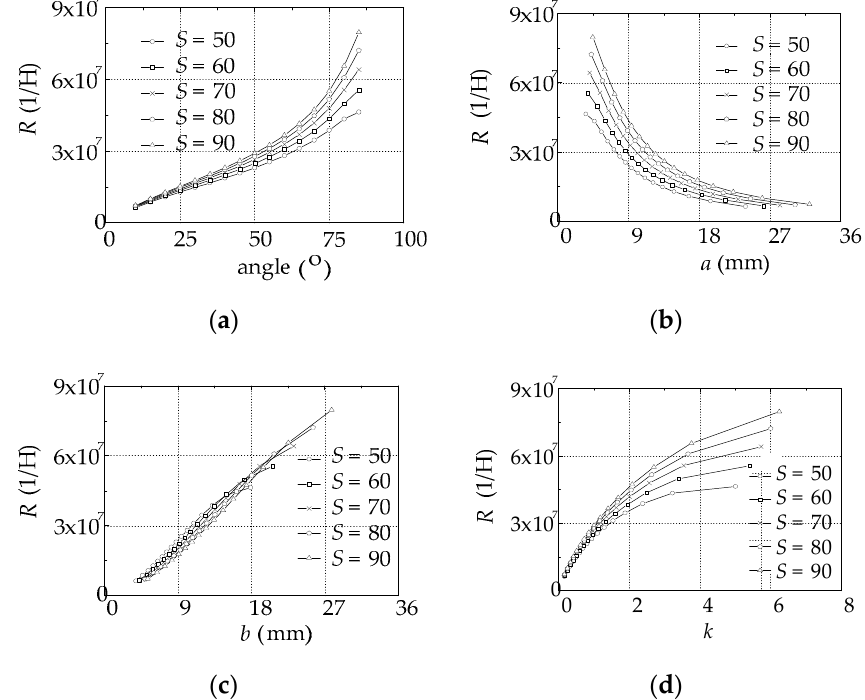
Figure 13. The magnetic reluctance versus θ , a , b and k : ( a ) the angle; ( b ) the length a ; ( c ) the length b ; ( d ) the ratio k . ( d ) the ratio k